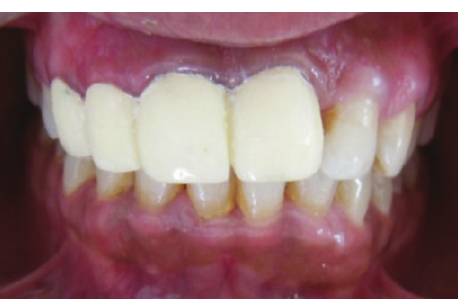
Figure 11: Flap retraction and exposure of bony defect.